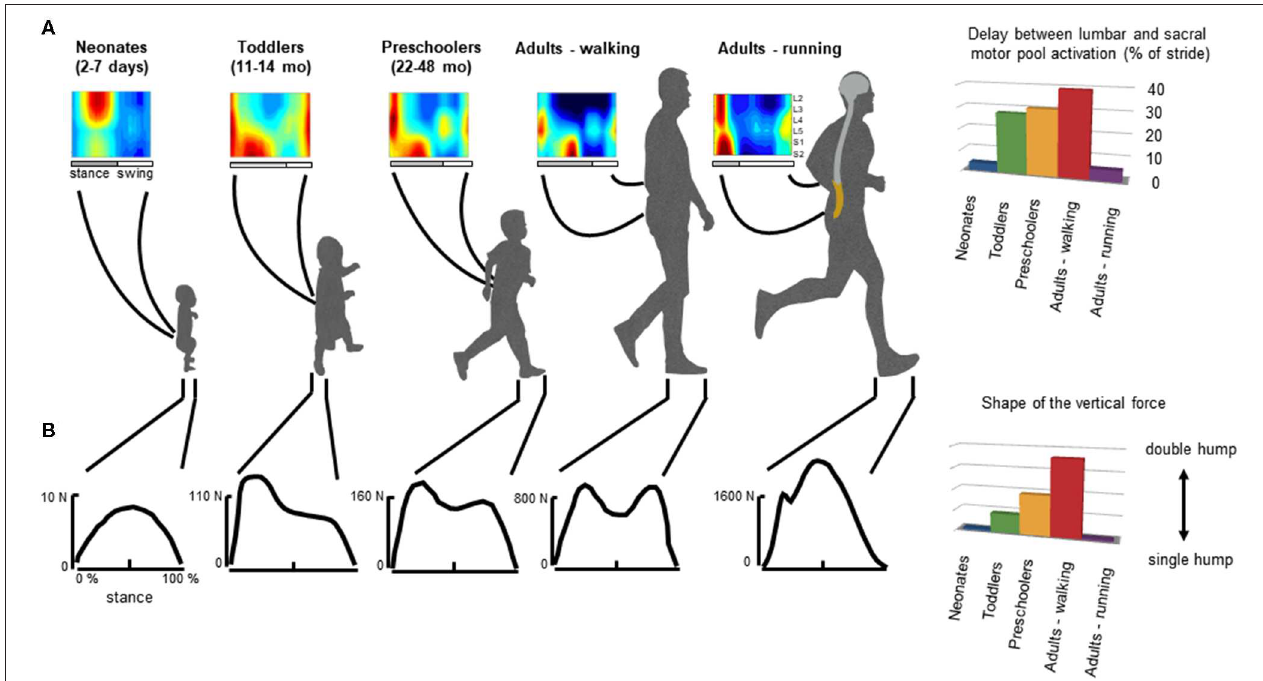
FIGURE 3 | General features of gait patterns from neonate to adult. (A) spatiotemporal maps of motoneuron activity of the lumbosacral enlargement in neonates, toddlers, preschoolers, and adults walking and running, and the delay between the maximum activation of lumbar and sacral motor pools (data from Ivanenko et al., 2013a for stepping, and Cappellini et al., 2010 for running). (B) typical vertical loading force during stepping in neonates, toddlers, preschoolers, and adults walking and running, and the characteristic force profile evaluated using an adapted ratio of the coefficients of Fourier series ( Hallemans et al., 2006a) providing a description of the main features of the shape of the ground reaction force: when the ratio is nil the force curve has a single hump whereas when the ratio increases, the force curve tends to have a double hump